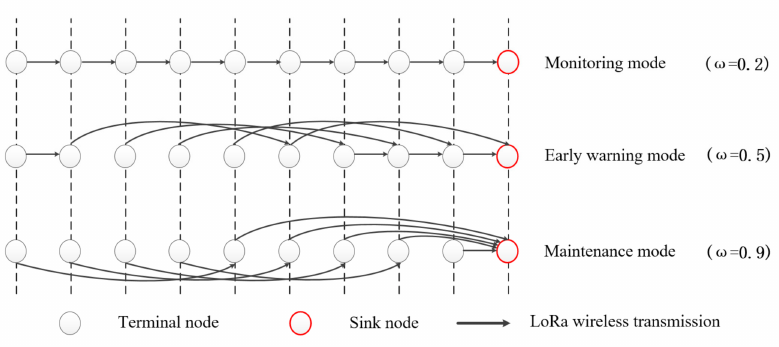
Figure 9. System networking mode under di ff erent working